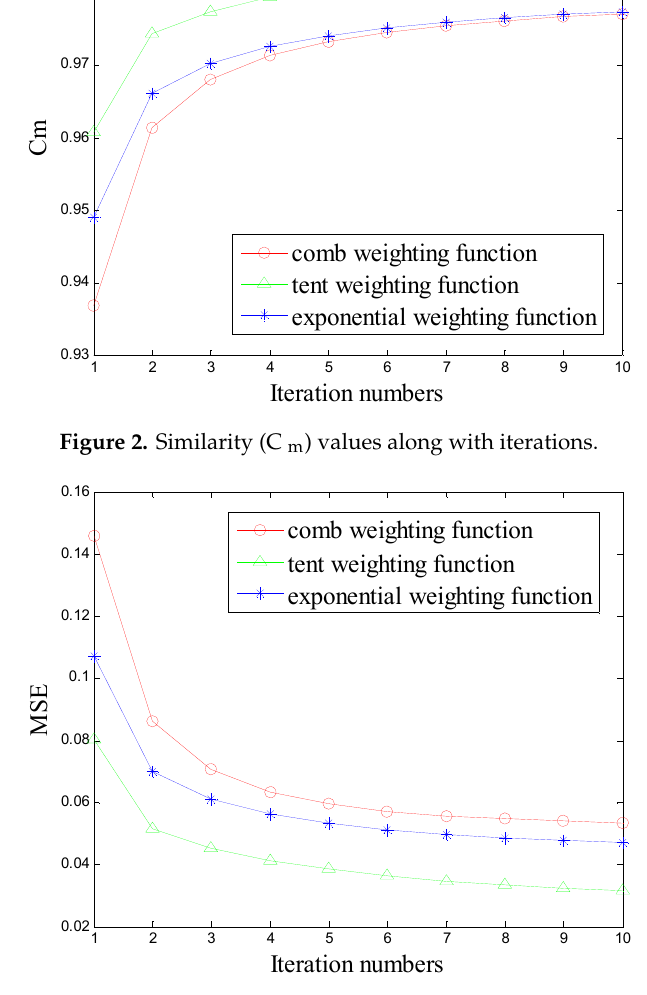
Figure 3. Mean square error (MSE) values along with iteration.